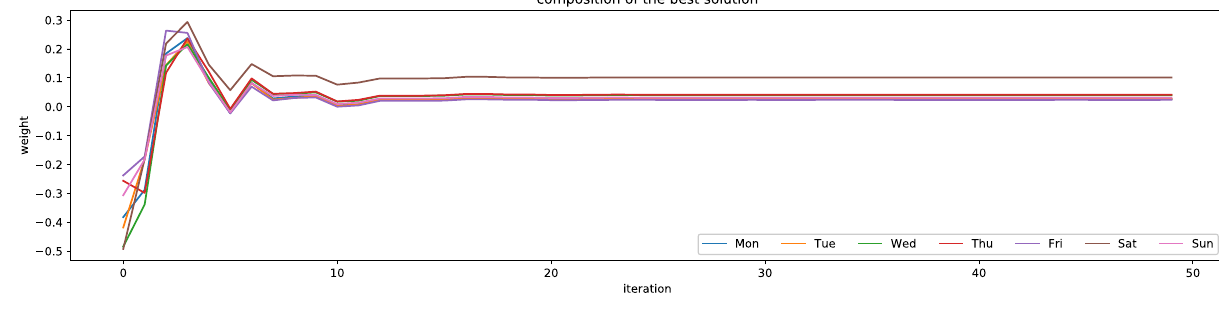
Figure 9. The evolution of the vectors of weekly periodicity in the successive